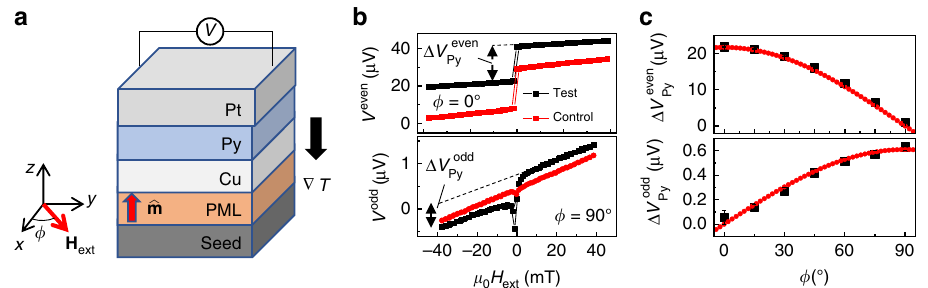
Fig. 4 Spin Seebeck effect-driven spin galvanic effect measurements. a Experimental con fi guration for the SSE-driven SGE measurements. b Voltages measured in the two different con fi gurations for the test sample (seed/PML/Cu/Py/Pt) and control sample (seed/PML/Cu/TaO x /Py/Pt). V even and V odd are the sum and difference of the two voltage curves when ^ m is polarized up and down, respectively. c Angle dependence of the voltage signals associated with Py switching. Here Δ V even is the fi rst term of V even in Eq. (9) and Δ V odd is the fi rst term of V odd in Eq. (9). The red curves are fi ts to Py Py Δ V even ¼ 21 : 7 cos π ϕ Py 180